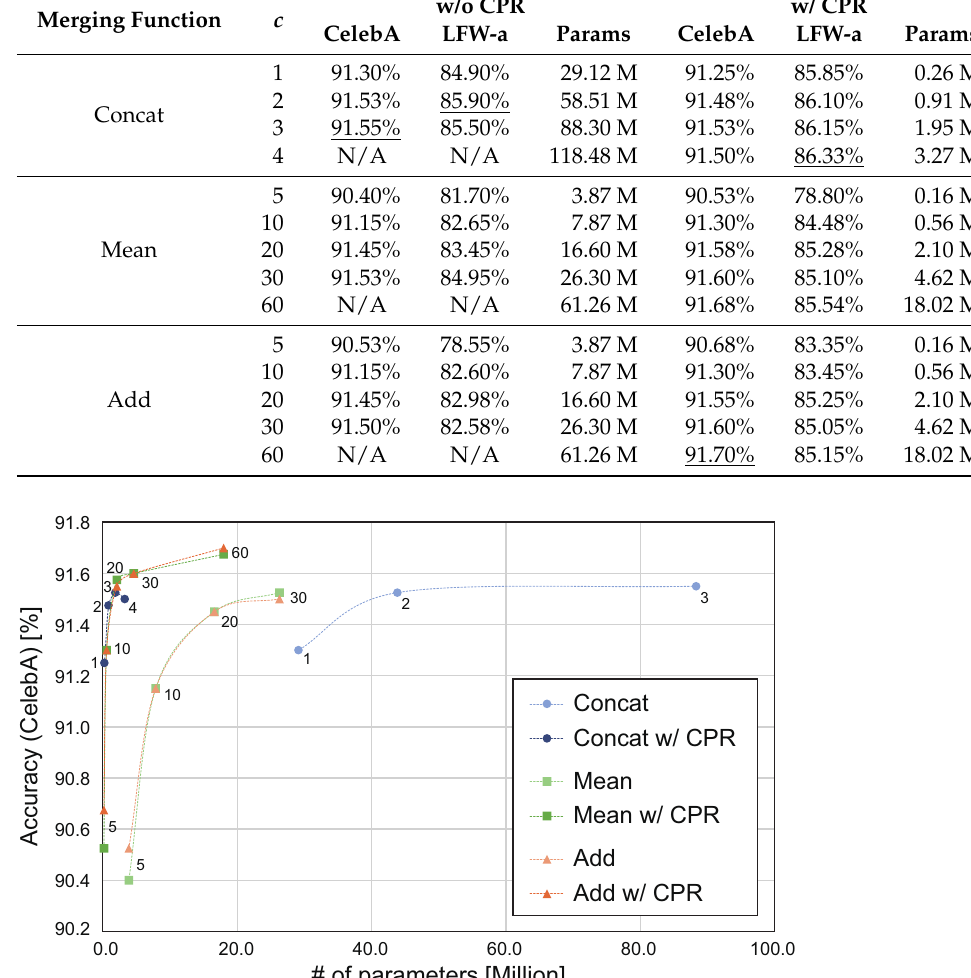
Figure 7. Comparison of the parameter efficiency of MM-CNN with different merge functions and c . The numbers near each point in the graph indicate the hyperparameter c